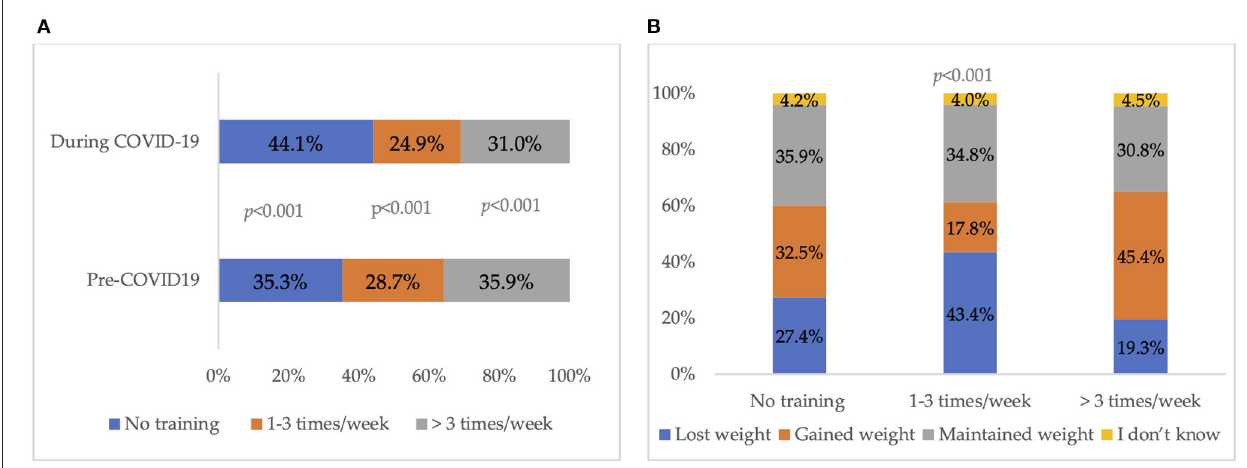
FIGURE 1 | (A) Frequency of physical activity pre-and during COVID-19 pandemic. The p values indicate the statistical significance of the McNemar test. (B) Physical activity during the COVID-19 pandemic with the perceived change in weight. The p values indicate the statistical significance of the Chi-Square test.